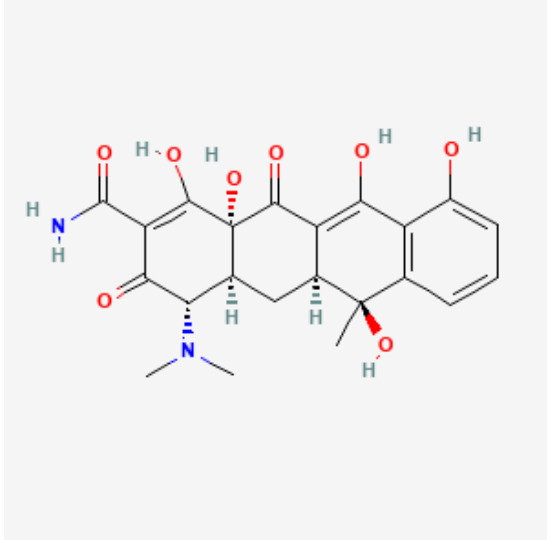
Figure 5. 2D chemical structure of